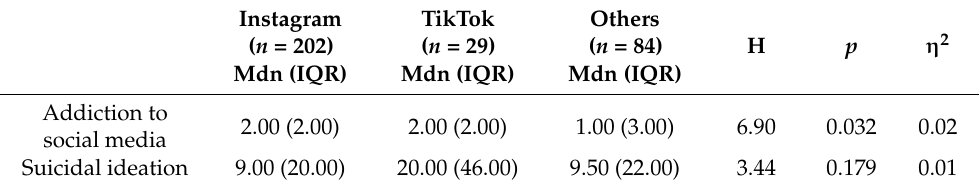
Table 1. Differences in social media addiction and suicidal ideation across platforms.